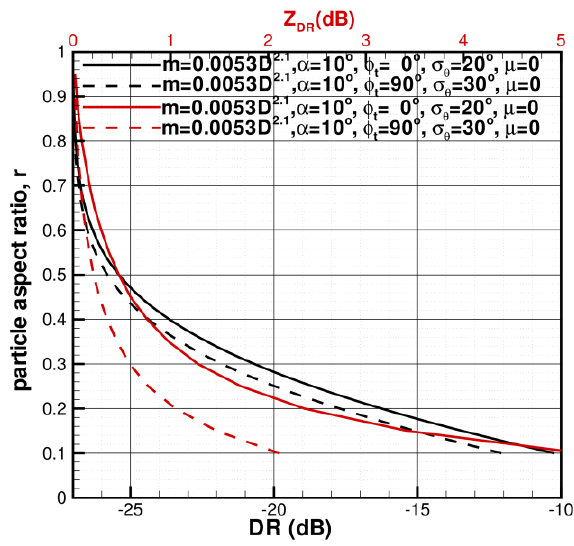
Figure 4. r -DR (lower X -axis, black curves) and r-Z DR (upper X -axis, red curves) relations for different particle wobbling parameters σ θ .